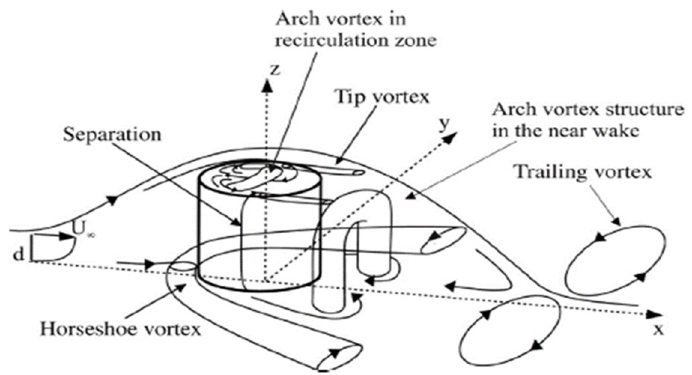
Figure 2. Schematic diagram of arch vortex formation for finite cylinders lower than the critical aspect ratio. (Reproduced with permission from [19], published by Springer Nature 2005.)